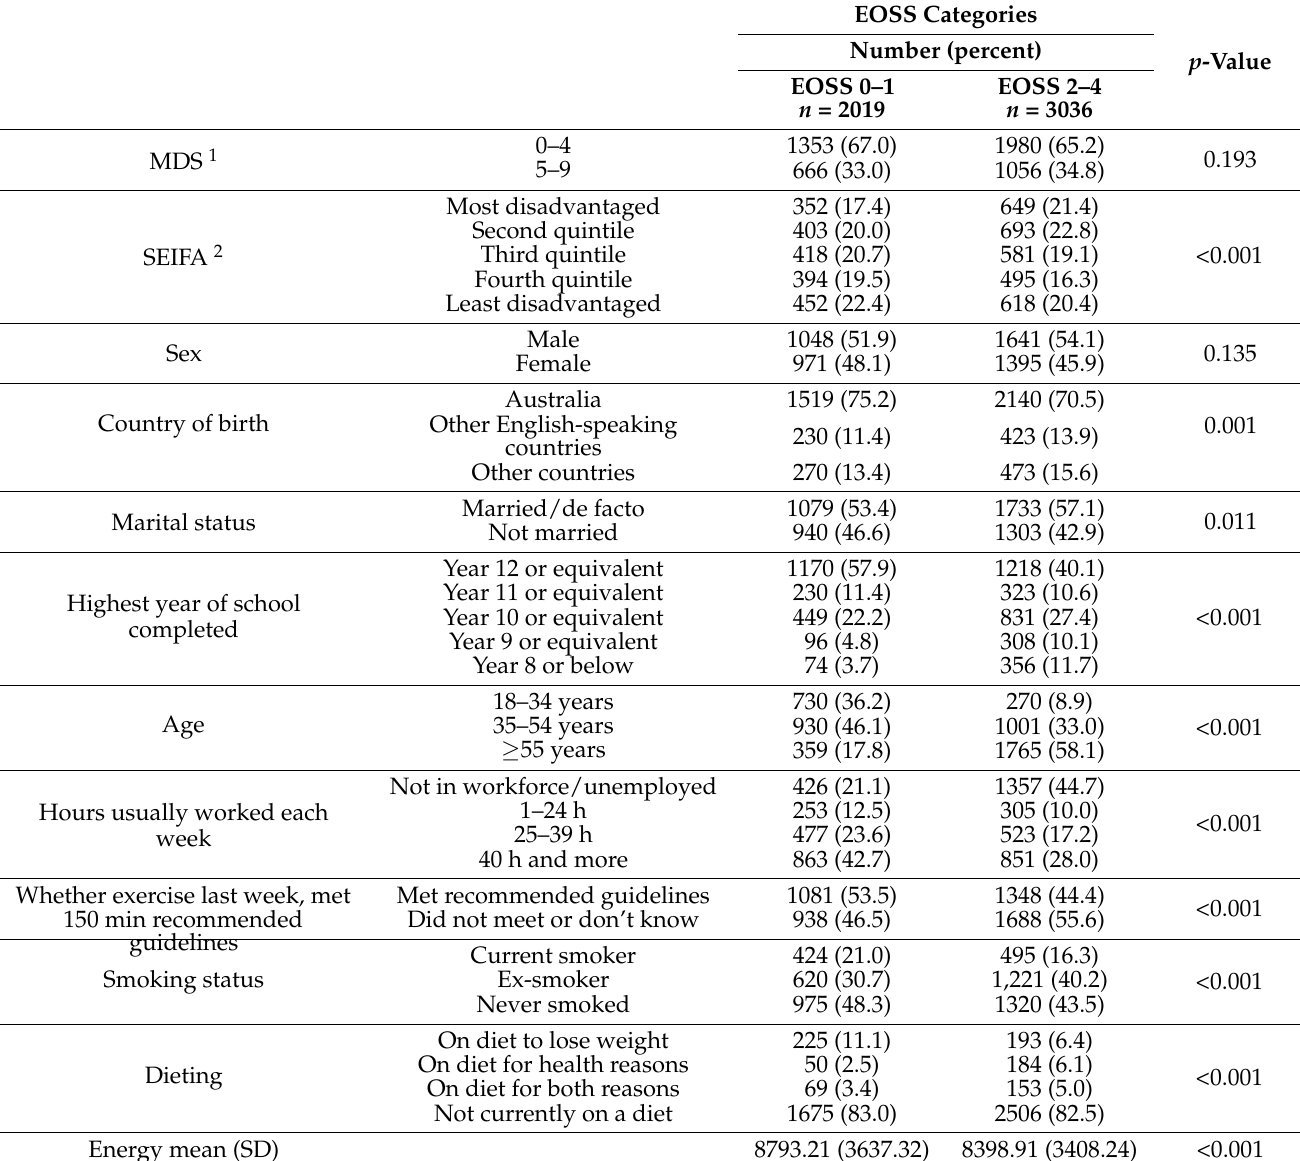
Table 1. Participant characteristics by EOSS category in the AHS 2011 to 2012 ( n =